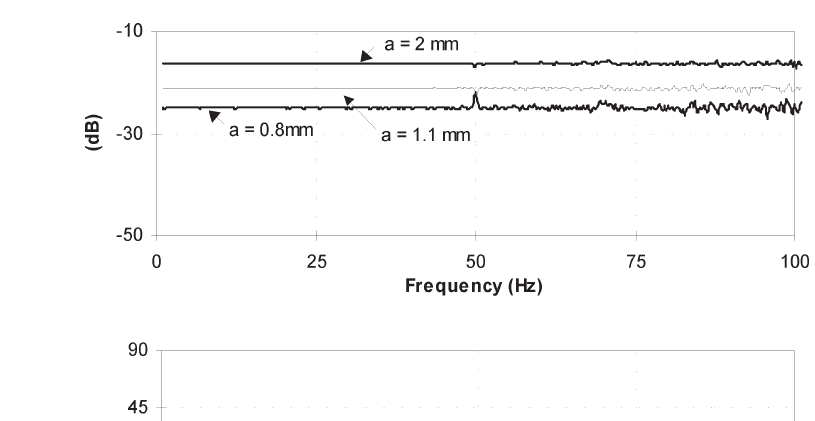
Fig. 3. Calibration of the PSD device.